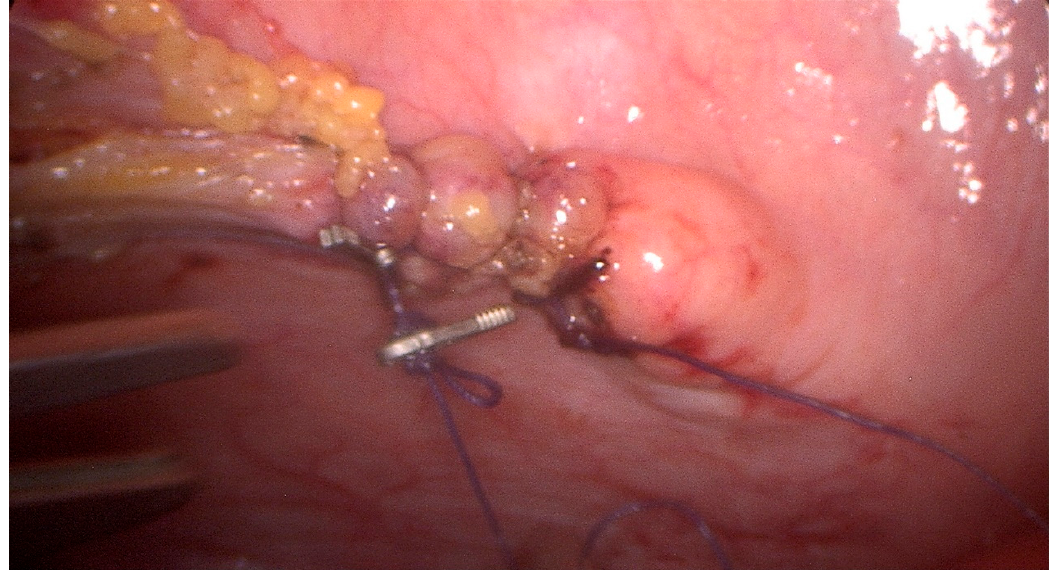
Figure 3. Single-layer continuous-locking repair of the bladder deficit with vicryl 1–0 and surgical clips for stabilization of the knots.